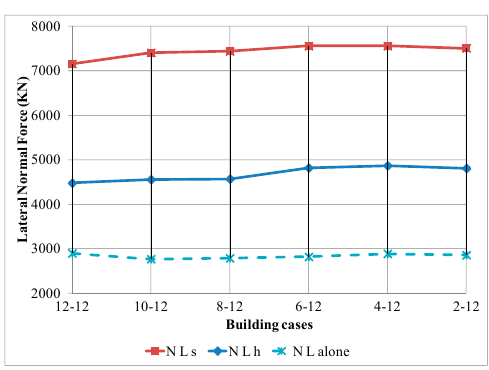
Figure 12. Lateral normal force at the foundation for the two adjacent and single buildings with SSI.